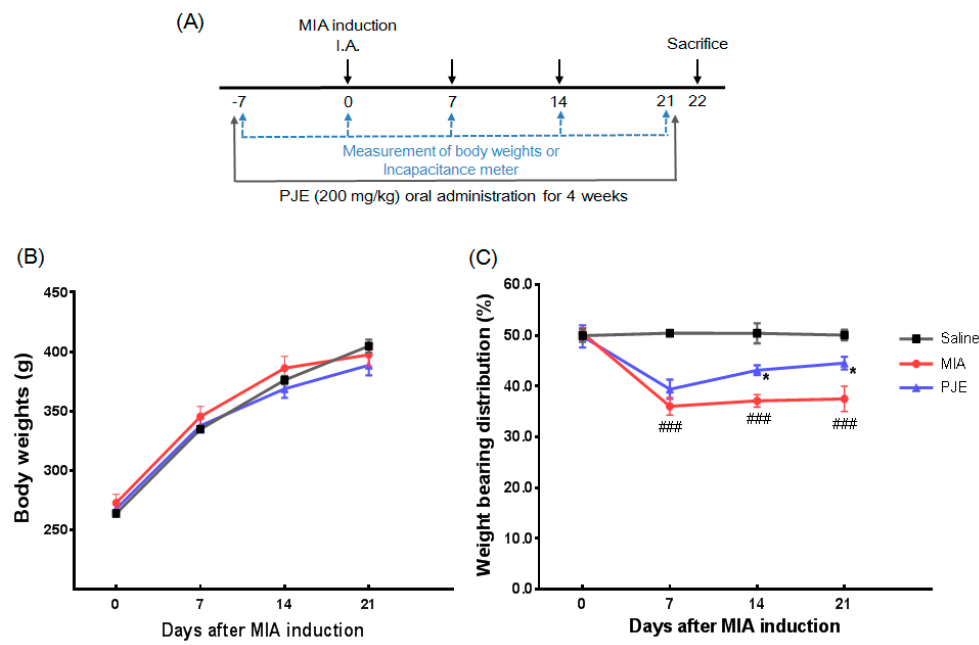
Figure 1. The experimental scheme and the effects of Peucedanum japonicum extract (PJE) on the hind paw weight bearing distribution in monosodium iodoacetate (MIA)-induced osteoarthritis (OA) model rats. ( A ) Experimental protocol used to induce osteoarthritis, followed by administration of PJE. I.A., intra-articular injection. ( B ) Body weights and ( C ) weight bearing distribution were measured (once per week for 21 days after injection of MIA) using an incapacitance tester. ### p < 0.001 vs. saline controls; * p < 0.05 vs. the MIA group.